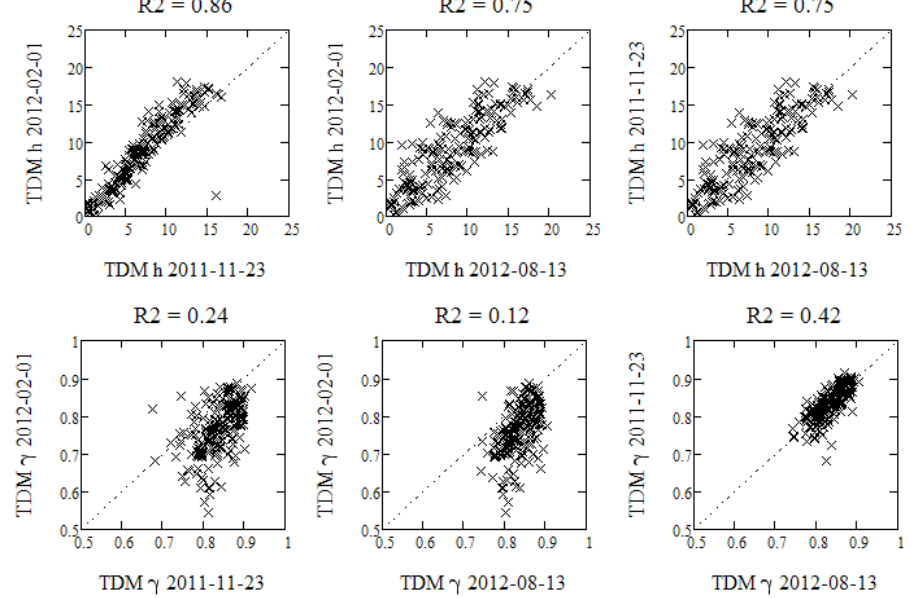
Figure 3. Temporal consistency visualized by means of scatterplots of stand-wise TDM height (TDM h, upper row) and TDM coherence (TDM  , lower row). HOA = 80 m for 2012-02-01, HOA = − 185 m for 2011-11-23, and HOA = 358 m for